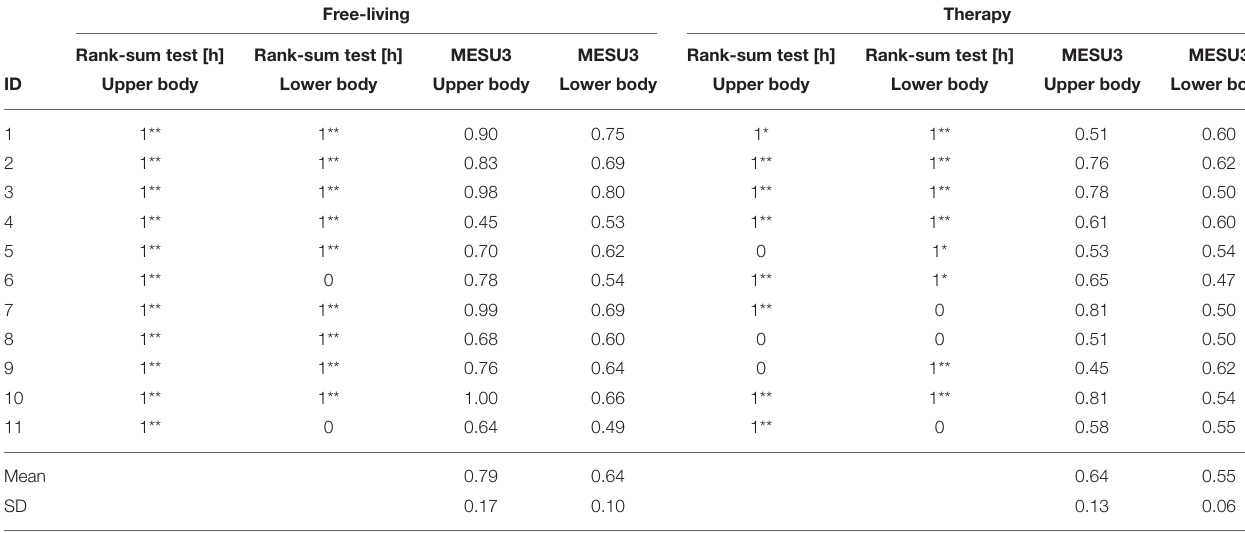
TABLE 3 | Statistical analysis of differences between affected and less-affected body sides for MET equivalents during free-living and therapy. Free-living Therapy Rank-sum test